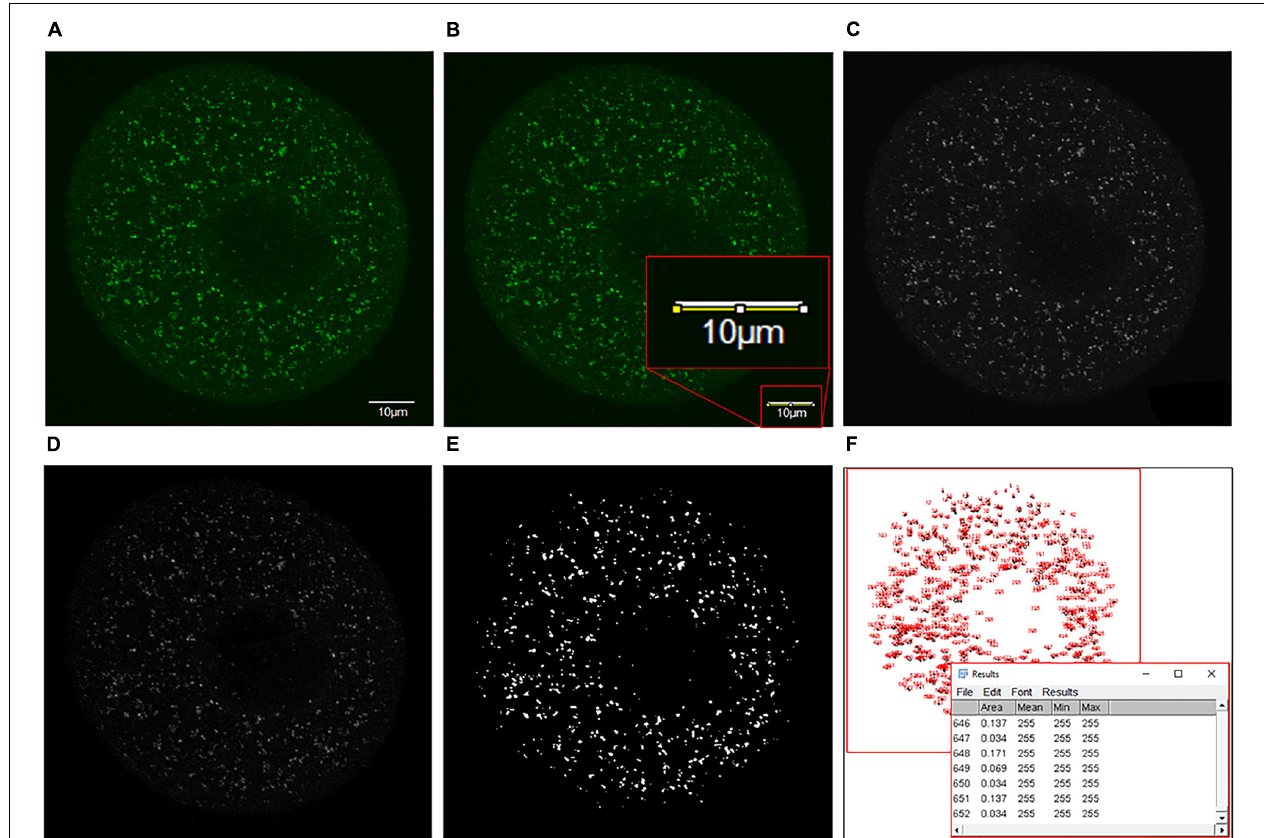
FIGURE 2 | Details of the puncta analysis method utilized to analyze puncta size distribution within immunolabeled oocyte images. (A) Firstly, the single-channel image of antibody staining to be analyzed with a scale bar of known size was acquired. (B) The scale bar was traced using the straight-line tool, and the scale of the image was adjusted from pixels to microns (Analyze > Set Scale > Input scale bar size as known distance). The scale bar was then circled and deleted using an area selection tool to remove from the image. (C) The image was converted to an 8-bit grayscale format for further analysis (Image > Type > 8-bit). (D) White top hat transformation (Plugins > Morpholibj > Morphological filters) was then performed. To do this, the ‘White top hat’ operation was selected, and parameters were adjusted to obtain a reduced background and enhance features of interest. (E) The image was then thresholded (Image > Adjust > Threshold) by selecting the threshold that most accurately represented the detail of the initial image ( T = 20 here). (F) Finally, the ‘analyze particles’ feature was selected (Analyze > Analyze particles) to produce a dialog box containing the number and size of each puncta measured. This information was copied into Excel, where puncta were sorted by size and categorized as